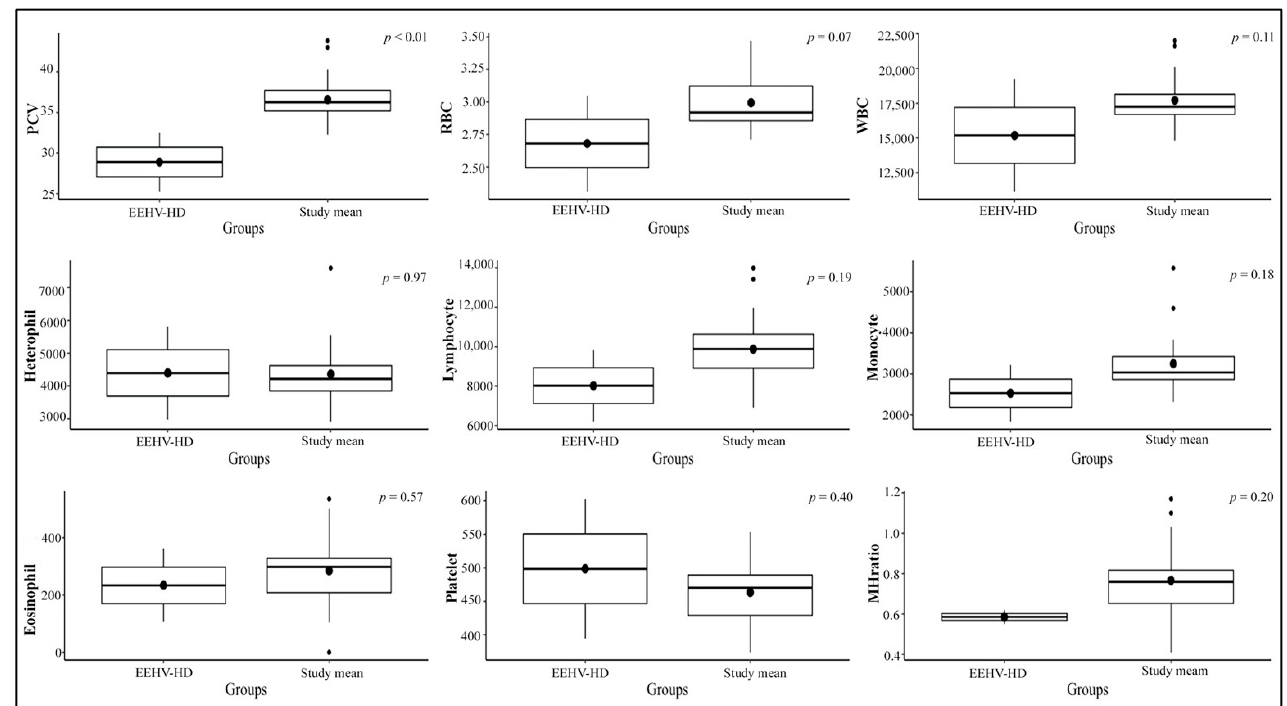
Figure 3. Boxplot presented significant differences in hematology between EEHV-HD and the study mean.